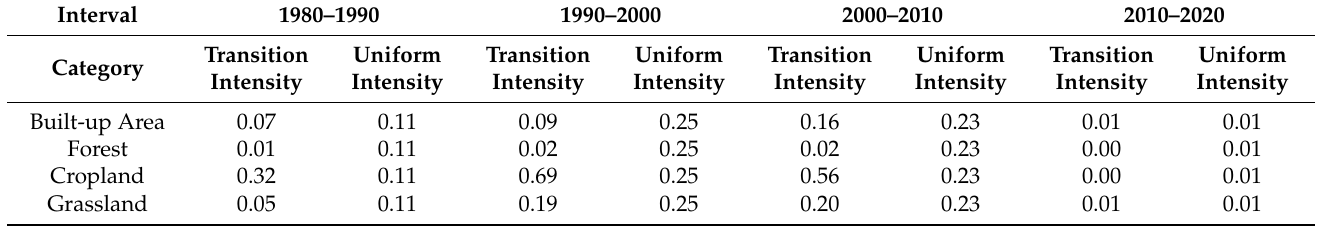
Table 23. Transition to Water.